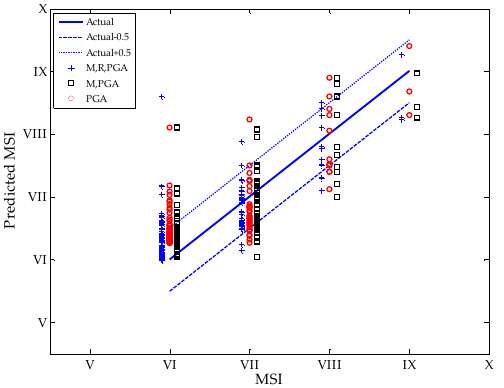
Figure 10. Performance comparison of the SVR model with and without earthquake magnitude and epicentral distance.